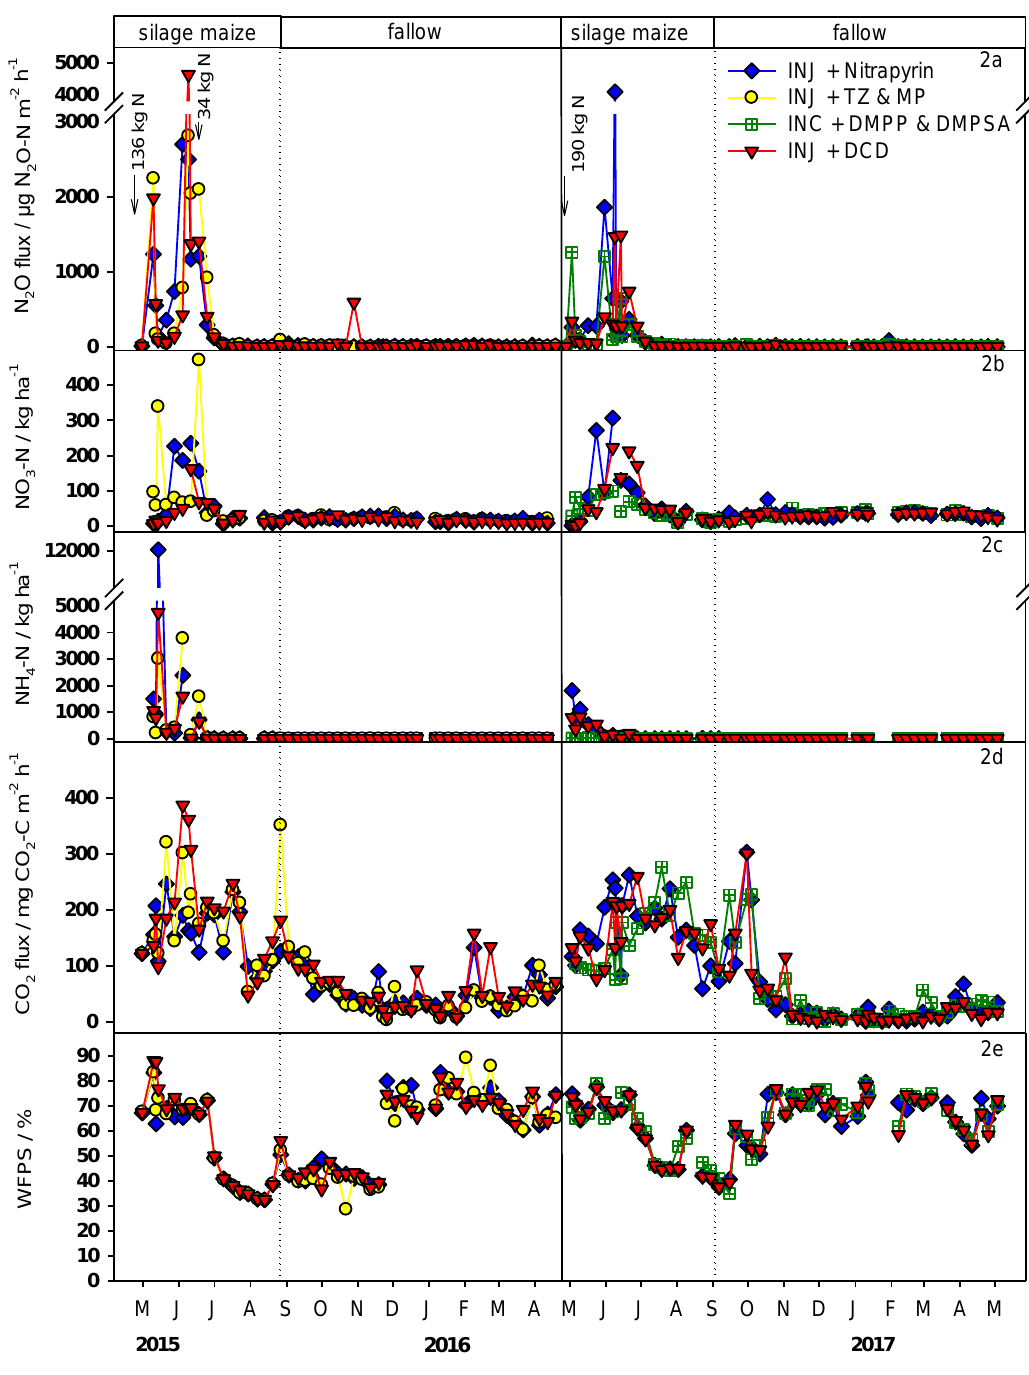
Figure 2. Mean N 2 O flux rates ( n = 4) ( a ), NO 3 − -N contents (0 − 30 cm) ( b ), NH 4 + -N contents (0 − 30 cm) ( c ), mean CO 2 soil flux rates ( n = 4) ( d ), and water-filled pore space (WFPS, 0 − 30 cm) ( e ) in the slurry injection treatments with nitrapyrin (INJ + nitrapyrin), DCD (INJ + DCD), TZ&MP (INJ + TZ&MP), and the slurry incorporation treatment (INC) with the combination of DMPP&DMPSA (INC + DMPP&DMPSA). Arrows indicate fertilization measures treatment. Error bars were omitted for clarity. During the cropping seasons, NO 3 − -N and NH 4 + -N contents of the treatments with injection are shown for the slot area.